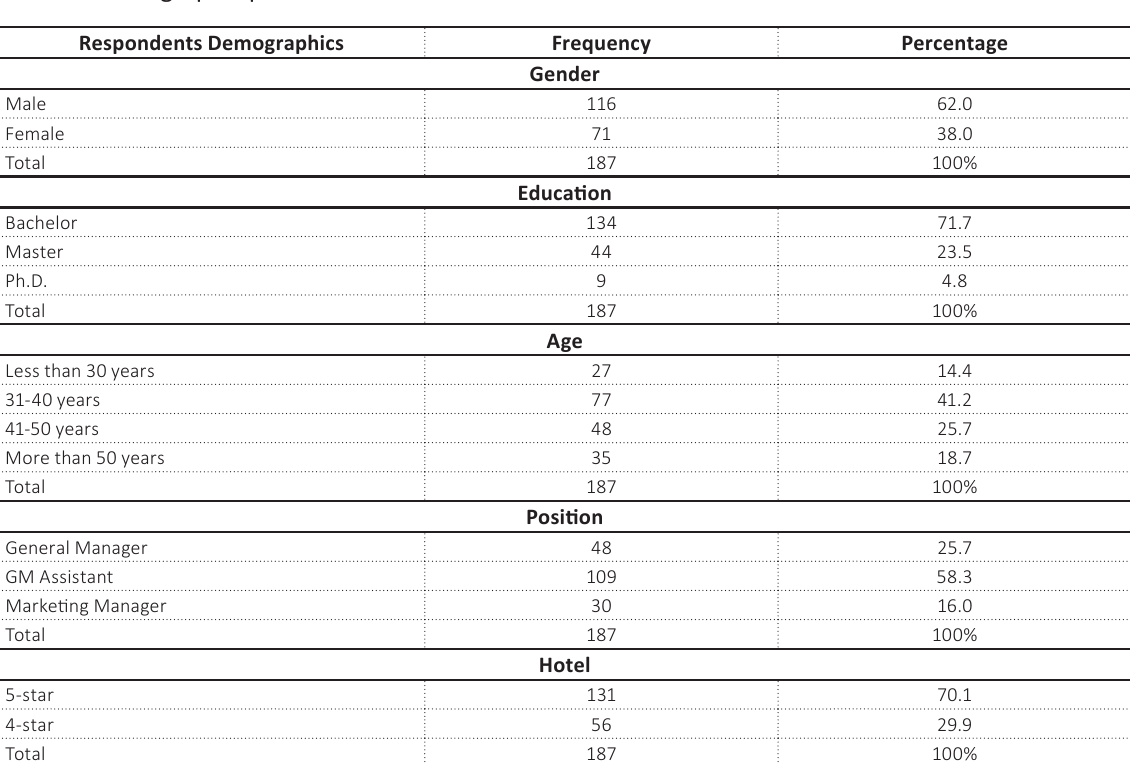
Table 3. Demographic